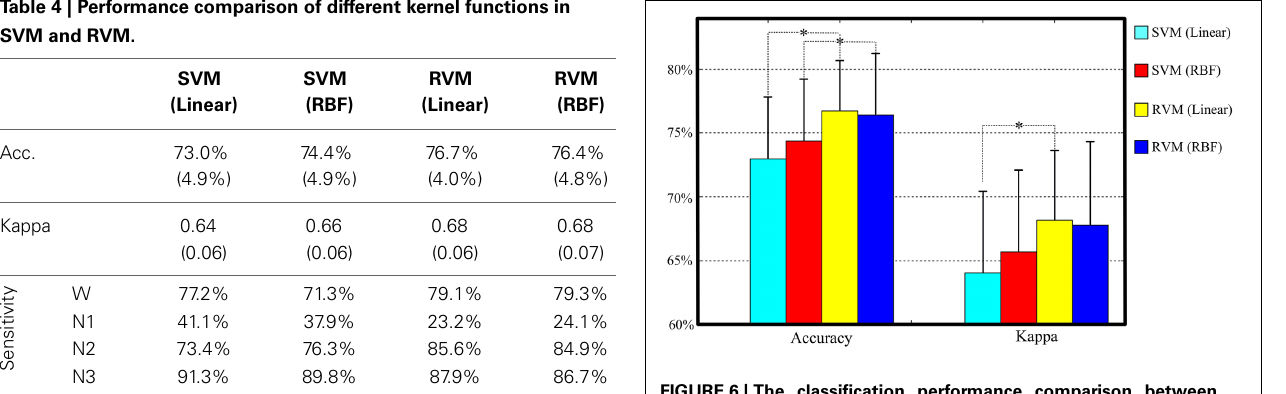
FIGURE 6 | The classification performance comparison between SVM and RVM with linear and RBF kernel functions. Acc. and kappa represents overall accuracy and Cohen’s kappa coefficient, respectively. Error bars indicate standard deviations. For better visualization, the kappa values have been scaled with the factor 100. ∗ p < 0 . 05.